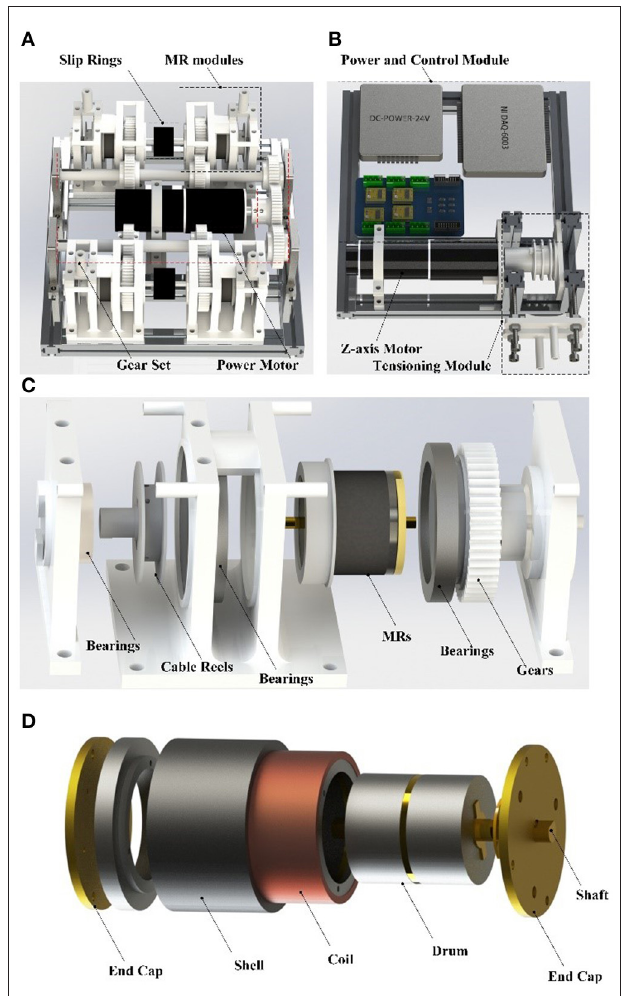
FIGURE 4 | The power box: (A) the upper layer, (B) the bottom layer, (C) the exploded view of the MR-Cable unit, (D) the MR clutch assembly.